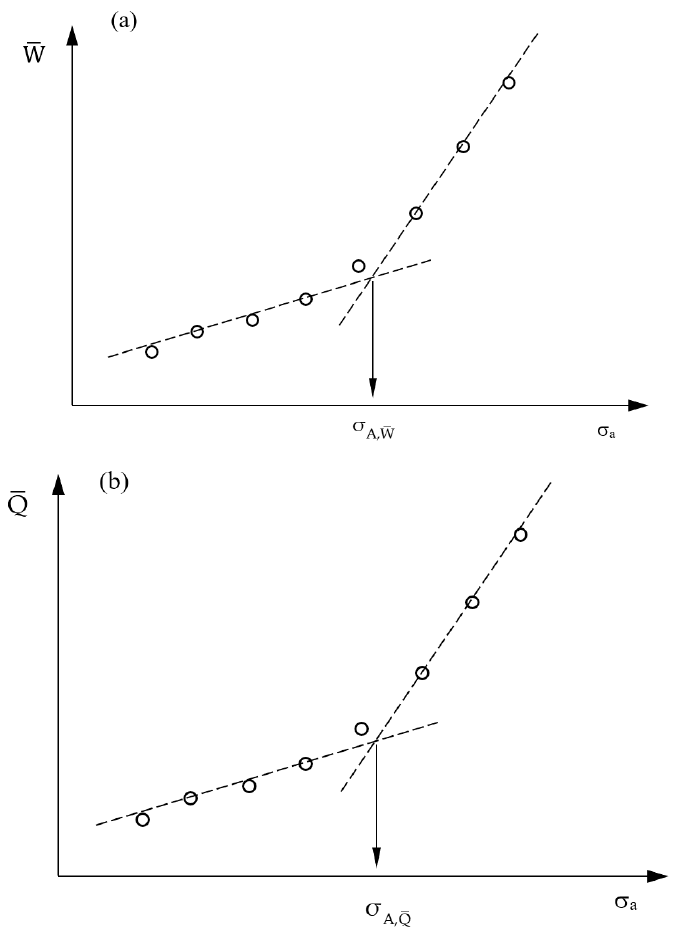
Figure 5. Rapid material fatigue limit evaluation assuming ( a ) the input mechanical energy per cycle and ( b ) the dissipated thermal energy per cycle as fatigue damage indexes.